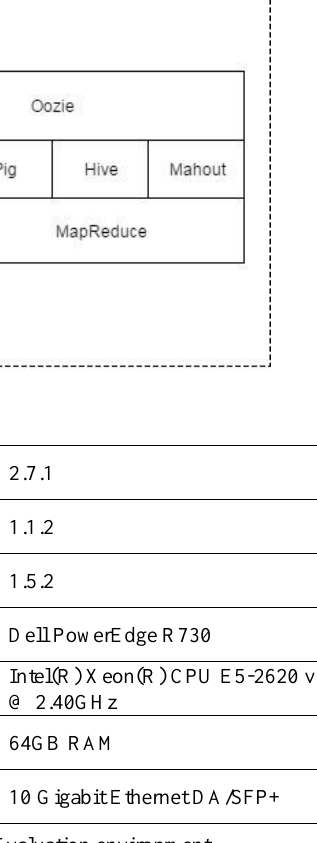
Table 2. Evaluation